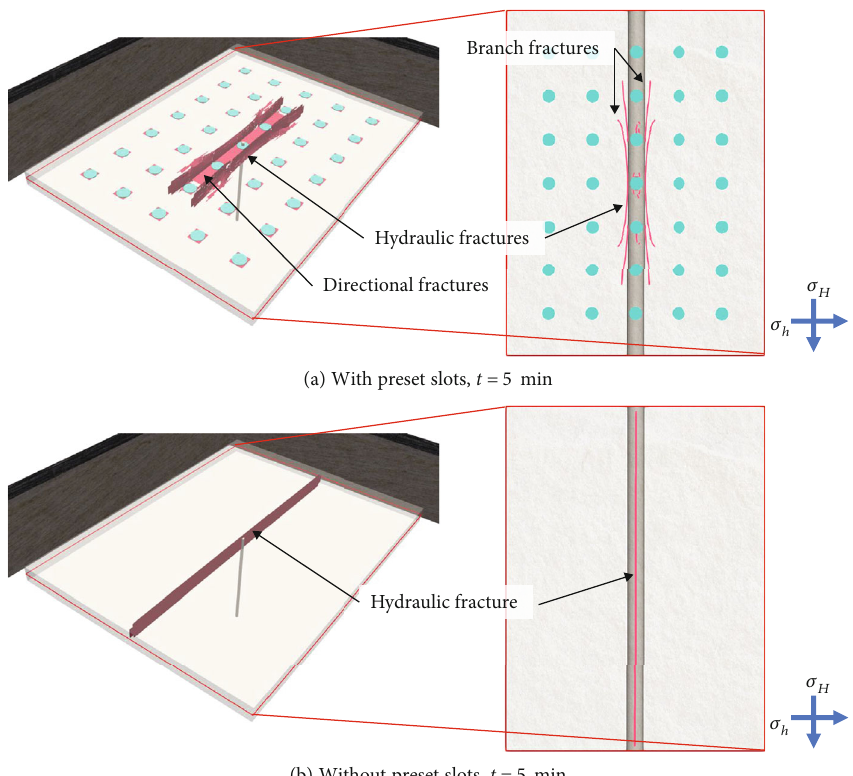
Figure 11: Comparison of hydraulic fracture patterns created by hydraulic fracturing (a) with and (b) without a regular distribution of hydraulic